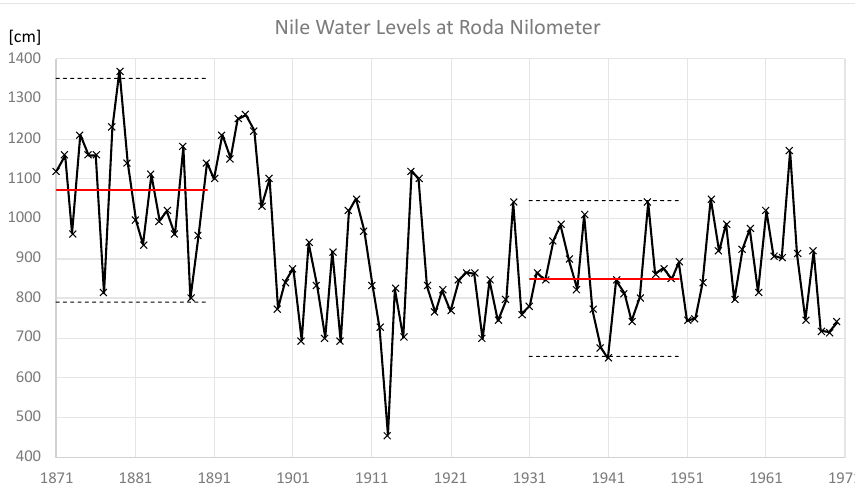
Figure 2. The monthly non-stationary water levels of the Nile at Roda’s Nilometer (in cm) during the period 1871–1971 considered as a weakly stationary stochastic process. We identified two 20-year sub-periods. Within each period, the stochastic process could be thought of as weakly stationary and ergodic, while the process over the 100-year period was clearly non-stationary.